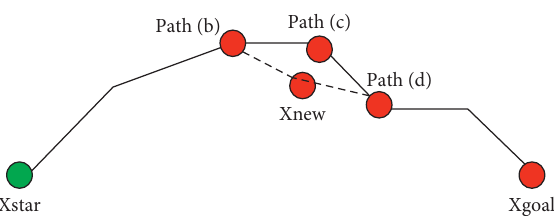
Figure 7: Schematic diagram of the optimized path by improved Informed-RRT ∗